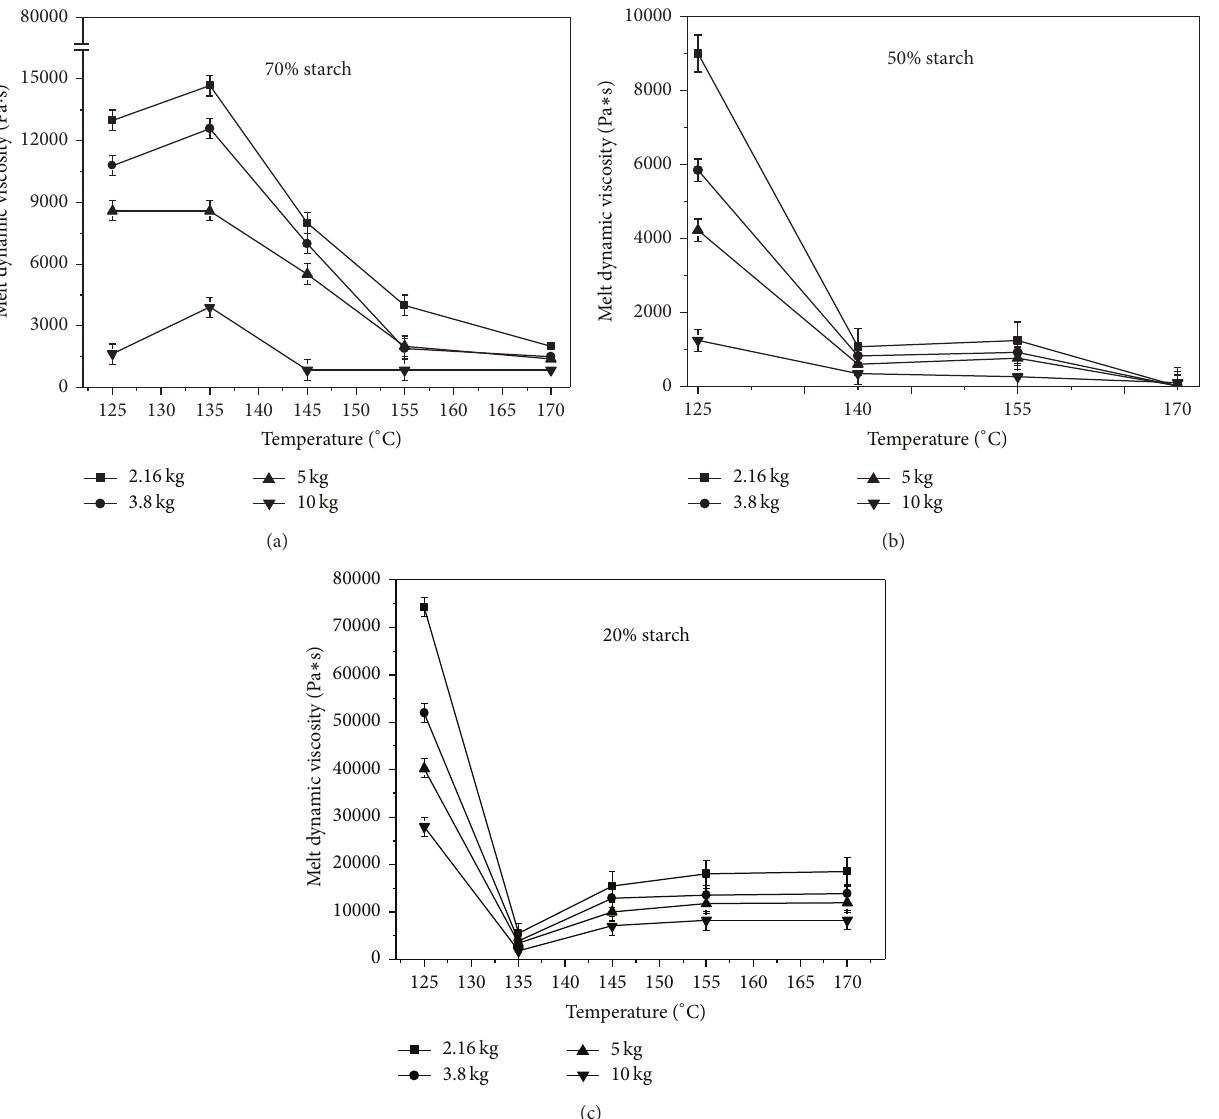
Figure 4: Dynamic viscosity versus temperature, load, and composition for the blends with (a) 70%, (b) 50%, (c), and 20% starch (line only for eliminating the confusions regarding the symbols’ affiliation to a certain